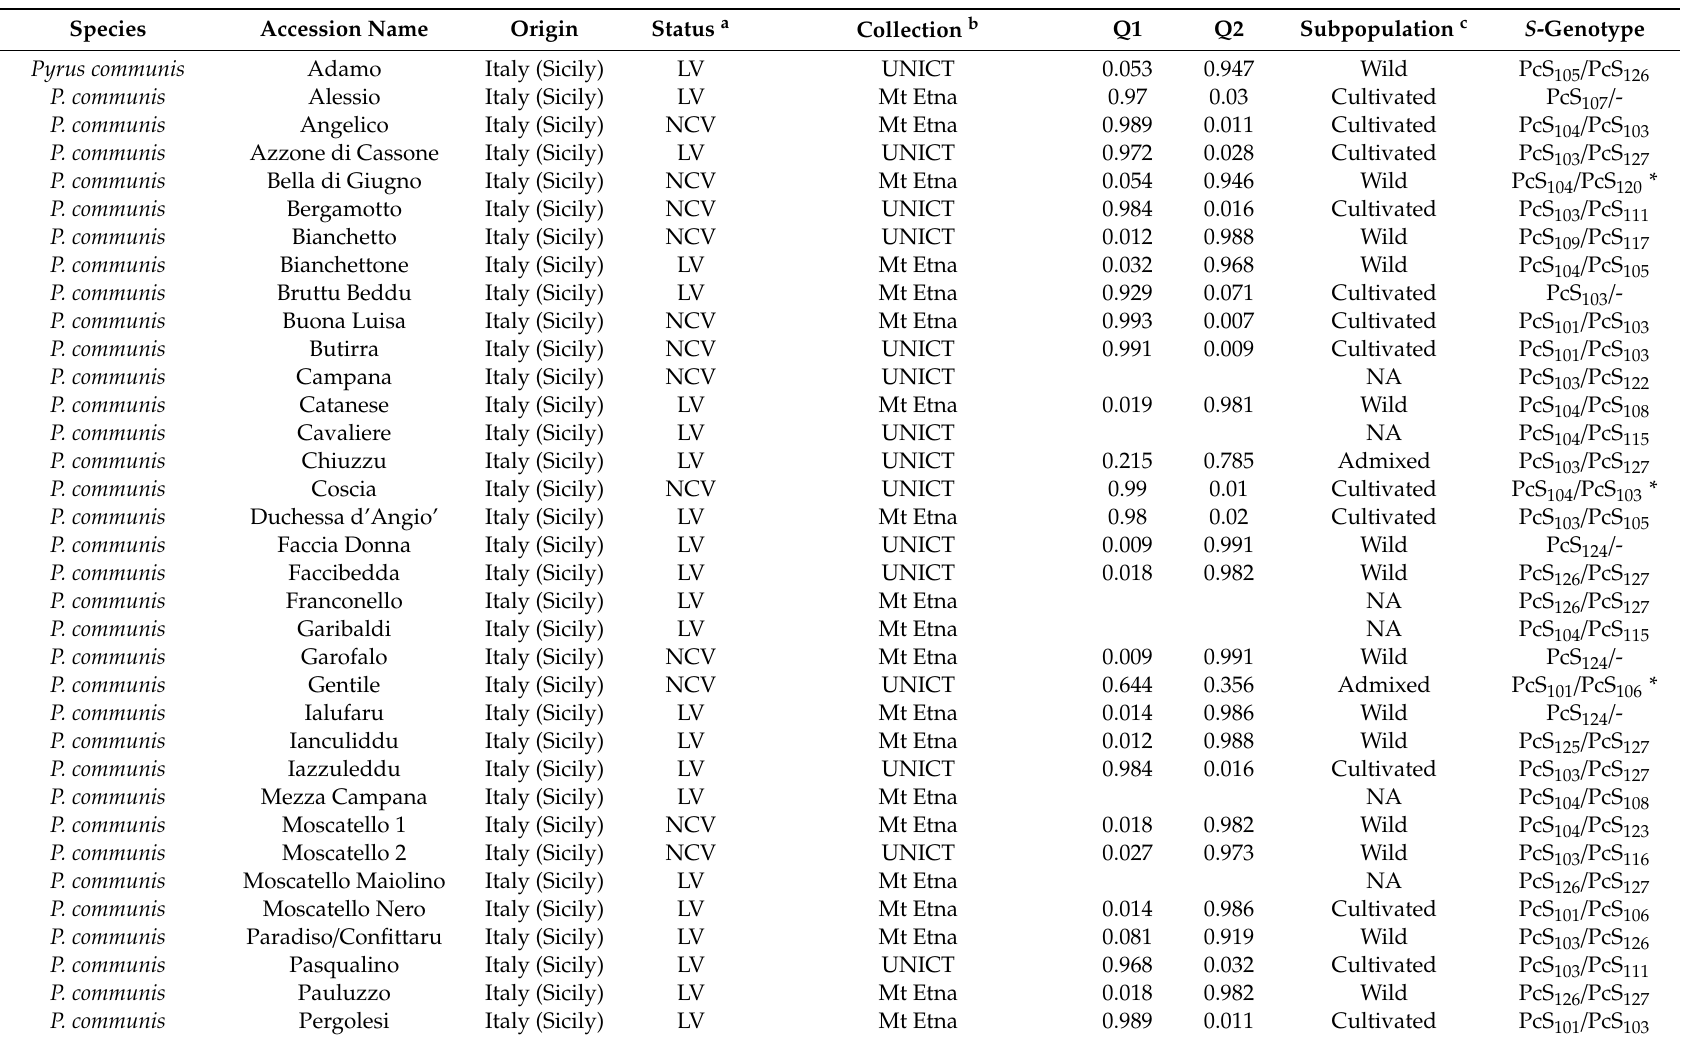
Table 1. S -Genotypes and features of accessions employed in this